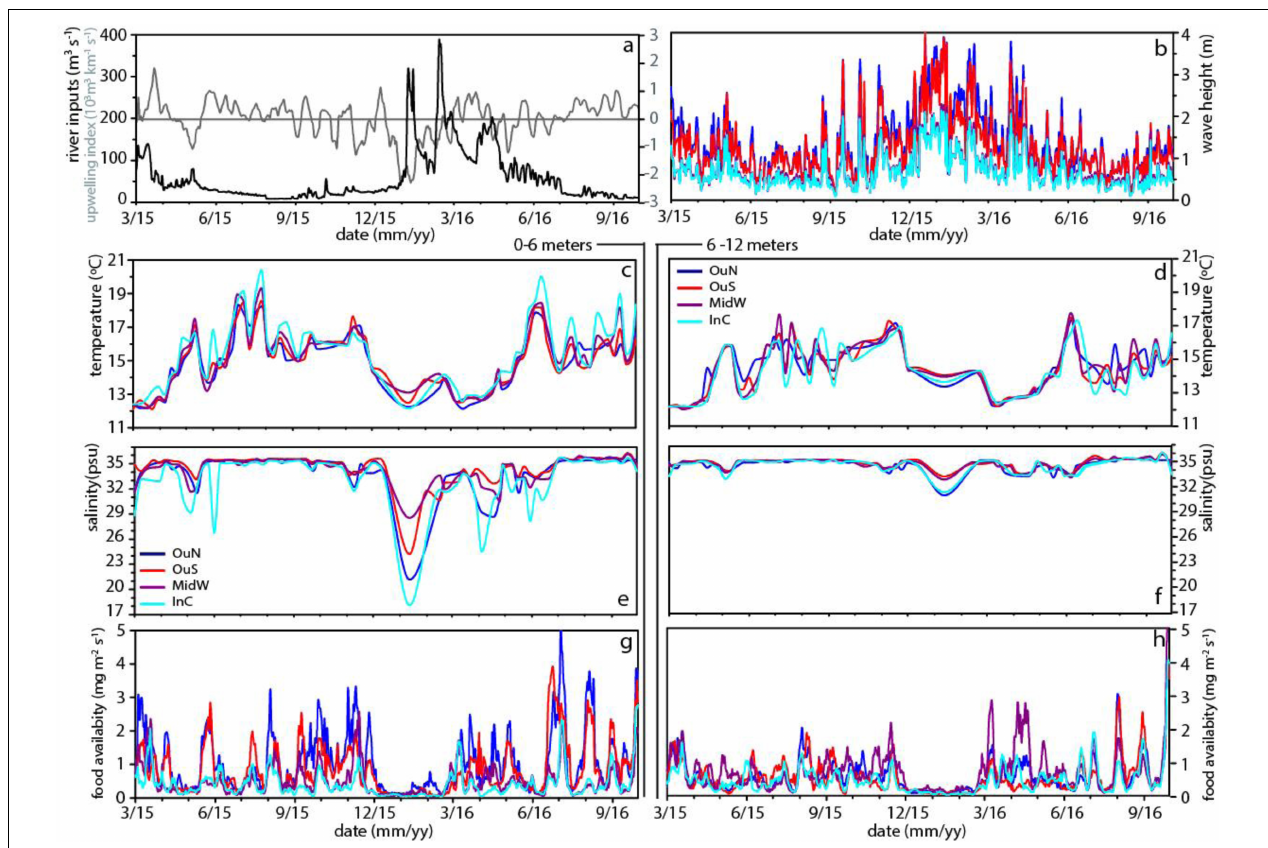
FIGURE 2 | Variability of the environmental parameters river discharge (m 3 s − 1 ; a ) and moving average of upwelling index with window size of 15 days (10 3 m 3 km − 1 s − 1 ; a ), wave height (m; b ), temperature for 0–6 m ( ◦ C; c ) and 6–12 m ( ◦ C; d ), salinity for 0–6 m (e) and 6–12 m (f) , total food availability for 0–6 m